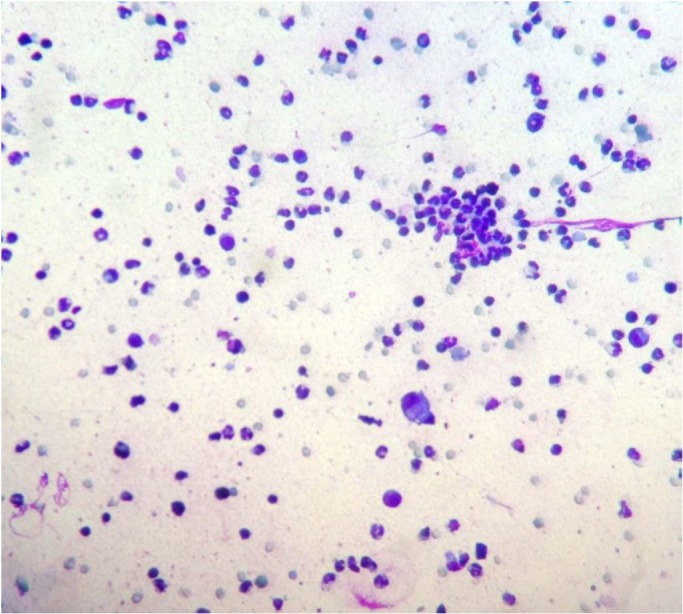
Gynecological examination in Pantaneiro mares. Endometrial cytology (mare 8) shows intense neutrophil infiltration and occasional macrophages. Panoptic staining, 40×.